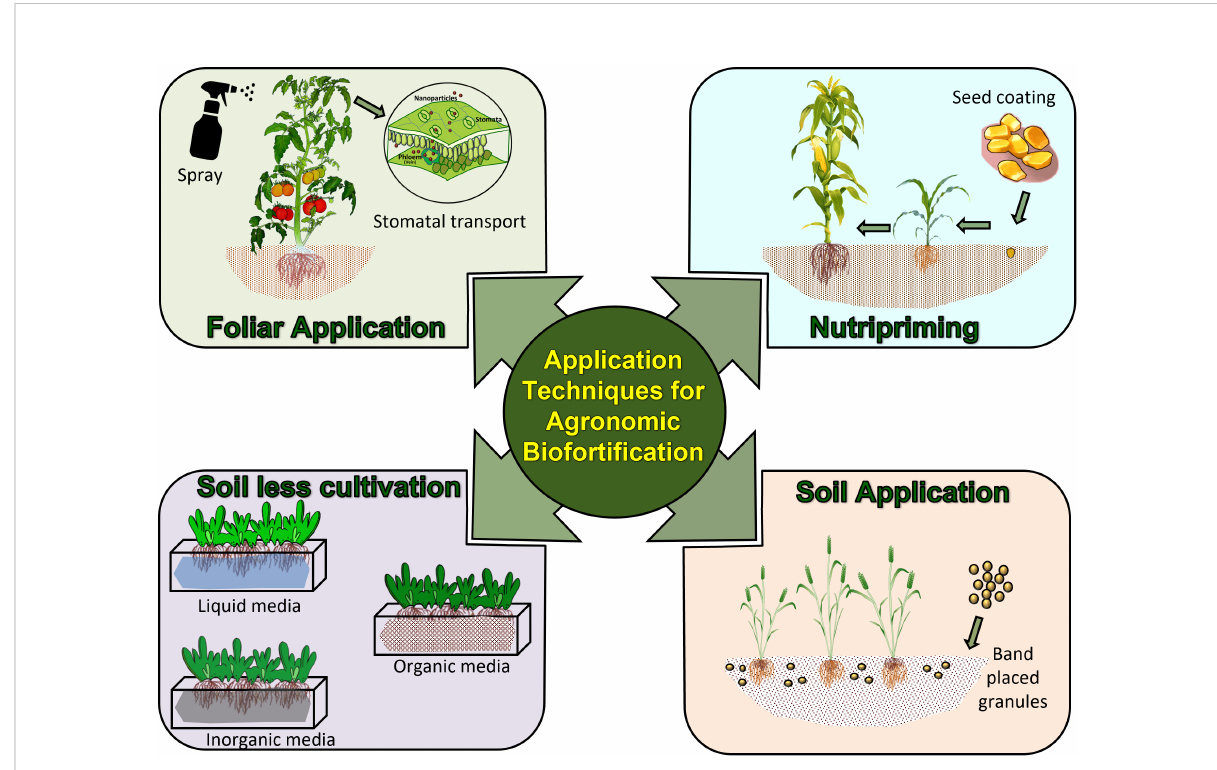
FIGURE 3 Application techniques used for agronomic bioforti fi cation of